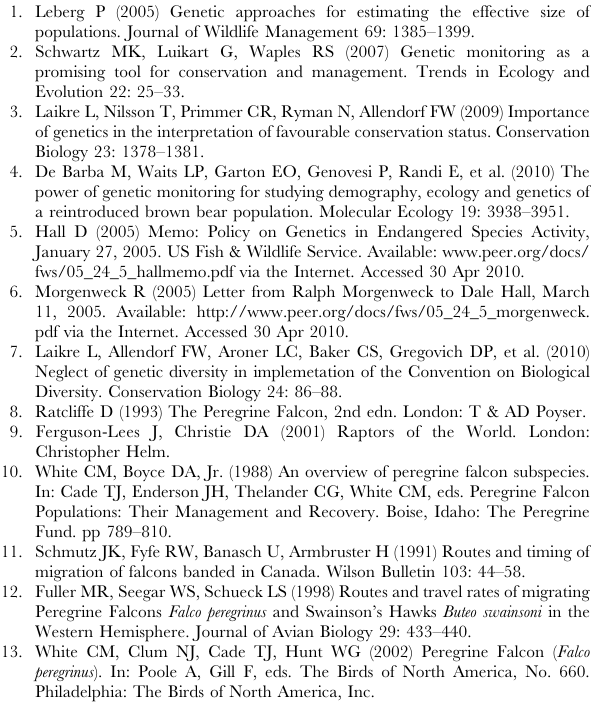
Table S1 Pairwise estimates of F ST (below diagonal) and D est (above diagonal) based on 11 microsatellite loci between regional peregrine falcon sample